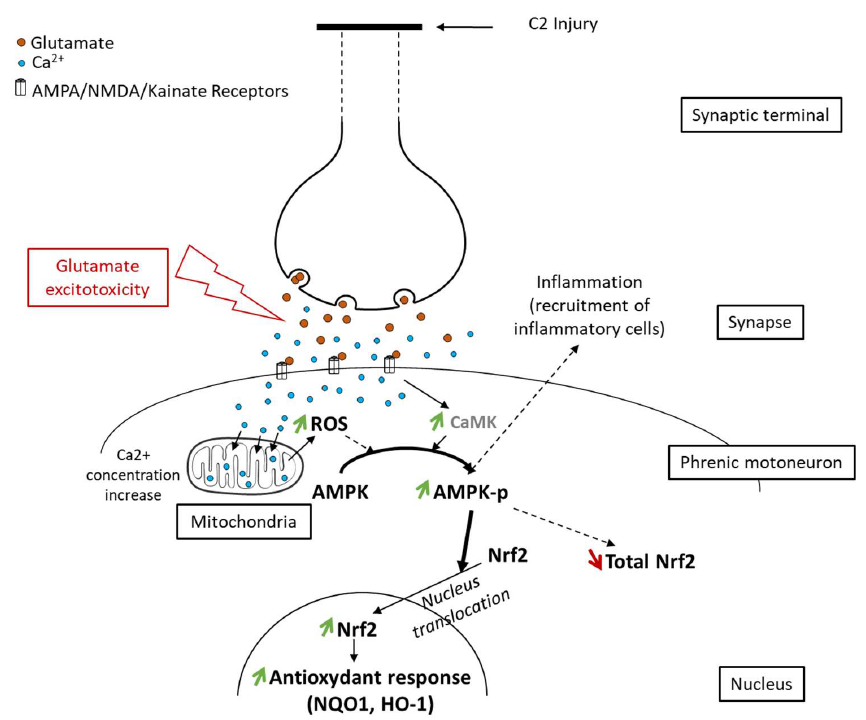
Figure 8. Proposed schematic of Nrf2 signaling pathway activation through phosphorylation of AMPK following spinal cord injury. Following axotomy, synaptic terminals release all their neuro- transmitters, including glutamate. This glutamate excessively activates its receptors (AMPA, NMDA, and Kainate), which leads to glutamate excitotoxicity in postsynaptic neurons (here, phrenic motoneurons). Intracellularly, it induces an increase in the calcium concentration, leading to increased reactive oxygen species (ROS) production by mitochondria. These ROS, associated with the increased calcium concentration, provoke AMPK phosphorylation. pAMPK then facilitates Nrf2 nucleus translocation, leading to an increase in the antioxidant response mediated by Nrf2 and its effectors (NQO1, HO-1).